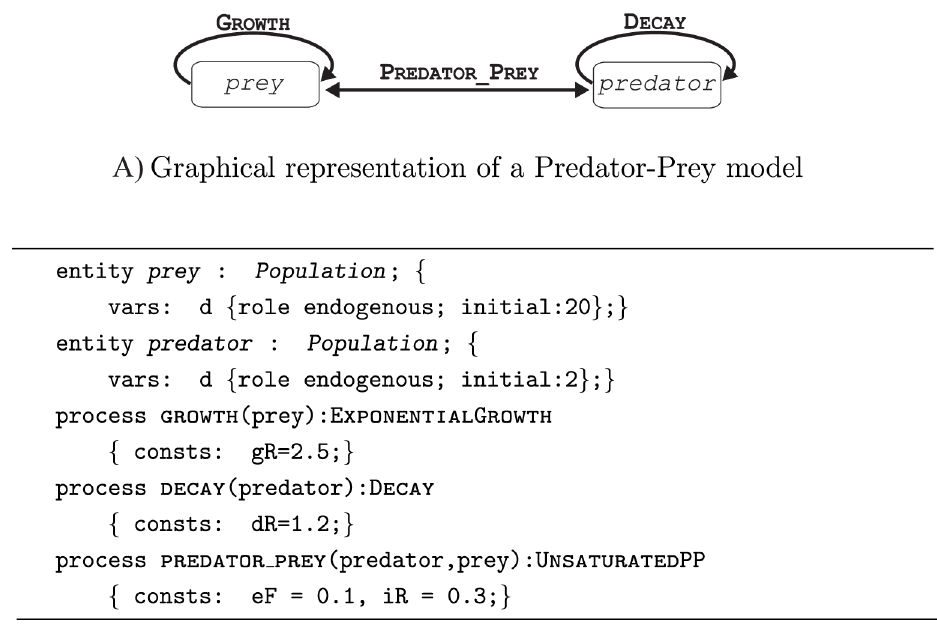
Fig 1. A simple Predator-Prey model and its process-based modeling representation. (A) A graphical representation of the entities (white boxes) and processes (black arrows) in a simple Predator-Prey model and (B) its process-based modeling